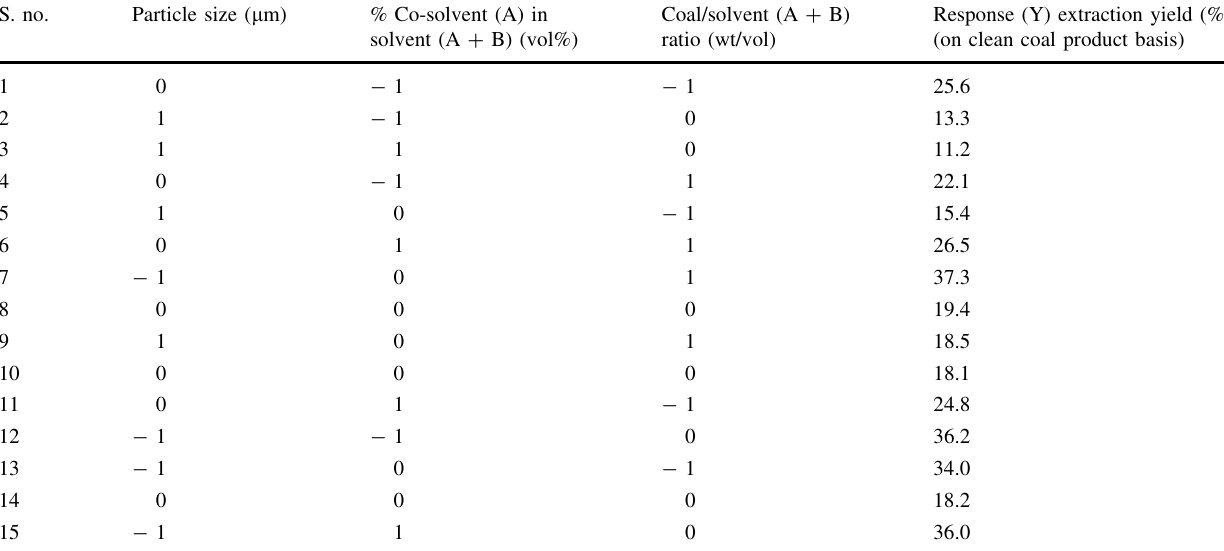
Table 7 The responses obtained for the design of the experiments RSM S.